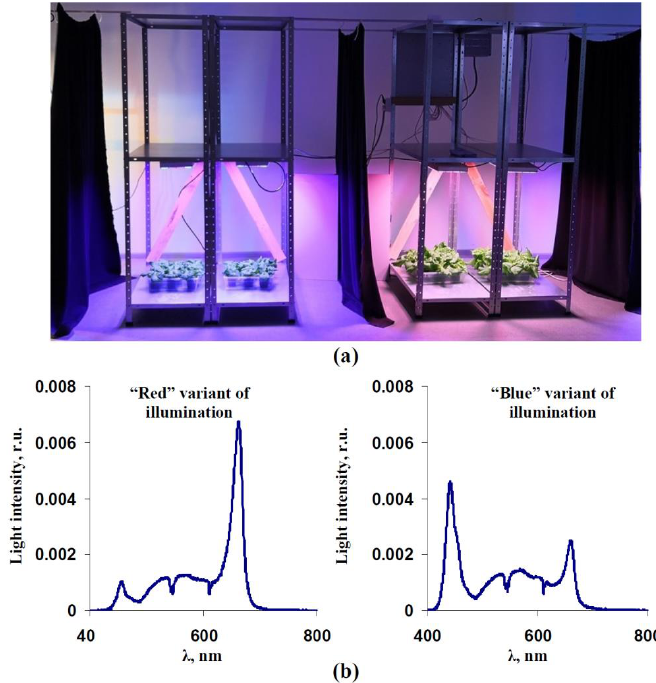
Figure 1. ( a ) Photo of the lettuce cultivation system. The system controlled the light intensity of three types of light-emitting diodes (LEDs, including blue, red, and white light sources) on each shelf that was used for plant cultivation. ( b ) Illumination spectra that were used during lettuce cultivation. The spectra were normalized on the total sum of intensities within 400–800 nm. The high intensity of the red LEDs and low intensity of the blue LEDs were used in the “red” illumination variant. The high intensity of the blue LEDs and low intensity of the red LEDs were used in the “blue” illumination variant. The intensity of the white LEDs was constant for both variants. The total light intensity was about 180 µmol m −2 s −1 . Light peaks were observed at 445 nm, about 570 nm, and 660 nm (the blue variant) and at 452 nm, about 570 nm, and 660 nm (the red variant).